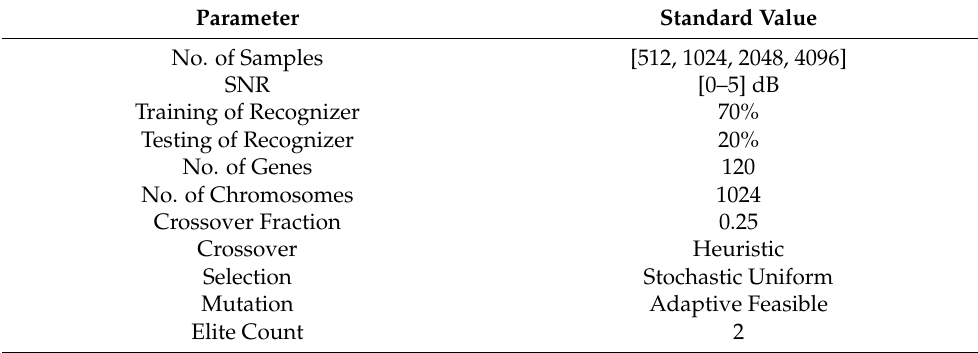
Table 3. Simulation parameters.